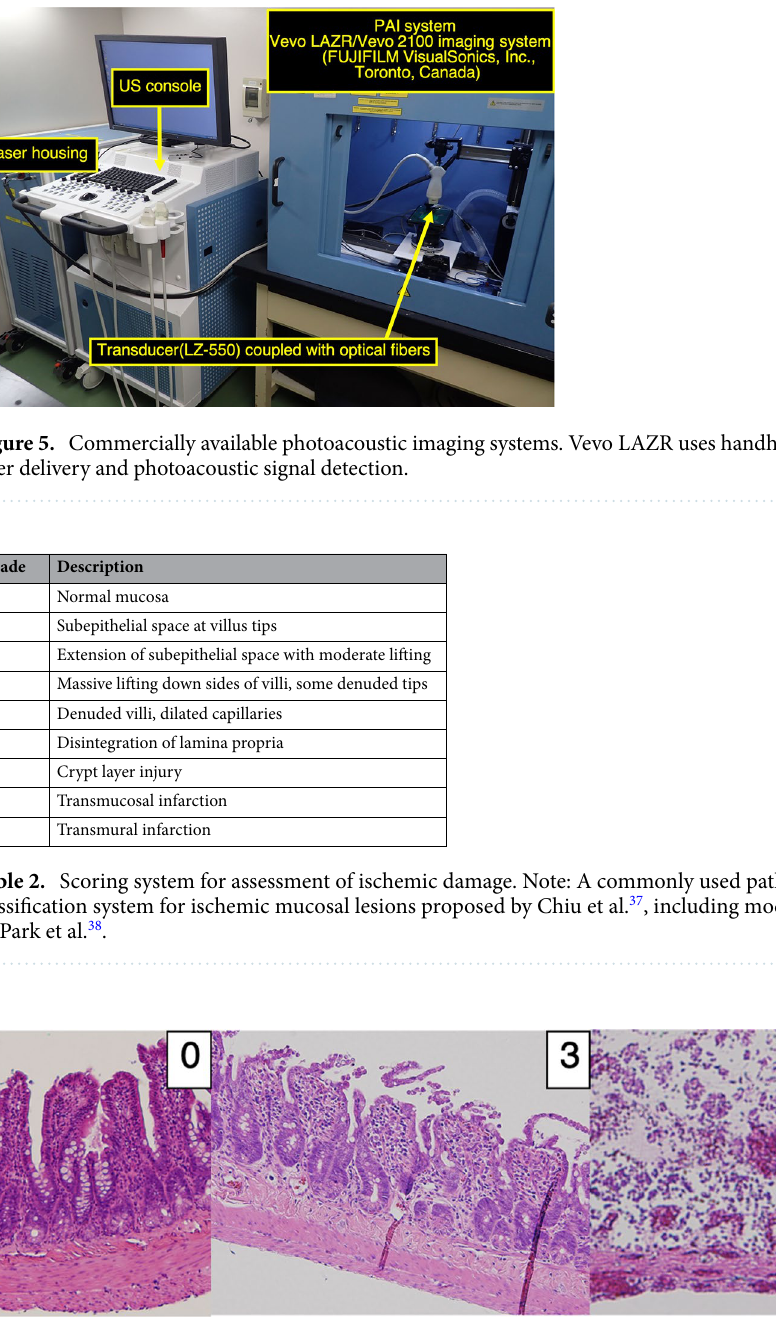
Figure 6. Examples of pathological findings with the pathological scores. 0, normal mucosa; 3, massive lifting down sides of villi, some denuded tips; 7, transmucosal infarction. With score 7, thrombi in small veins are